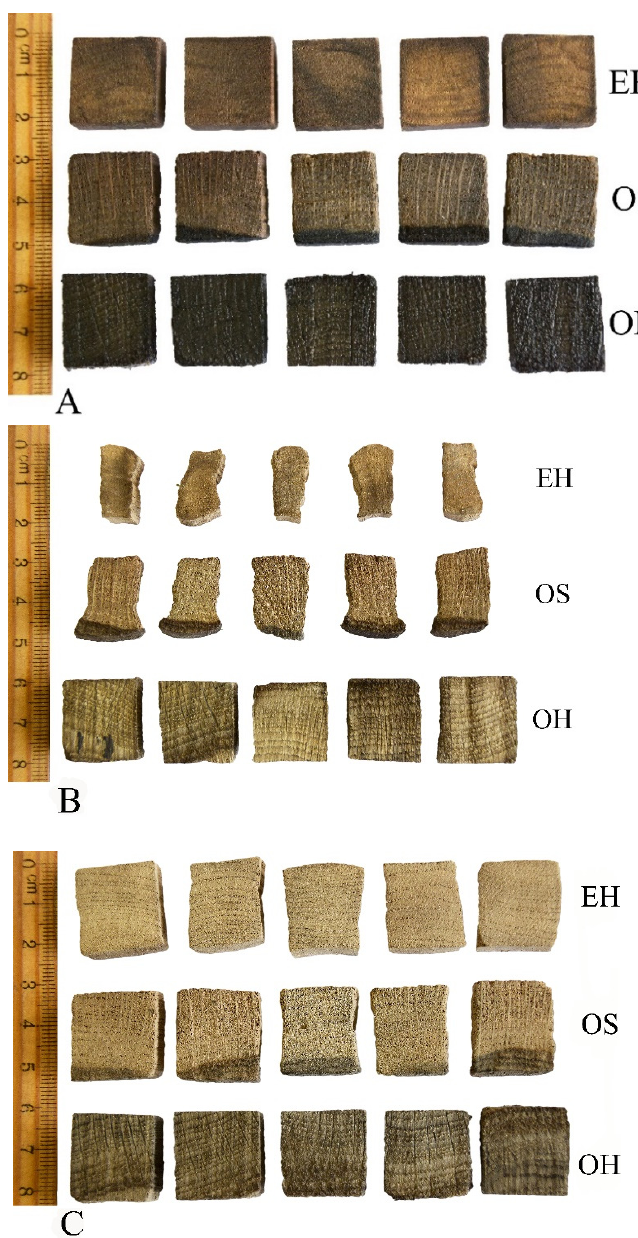
Figure 1. Archaeological wood samples: ( A ) waterlogged untreated and before any drying; ( B ) air-dried untreated; ( C ) air-dried MTMS-treated; EH—elm heartwood, OS—oak sapwood, OH—oak heartwood.